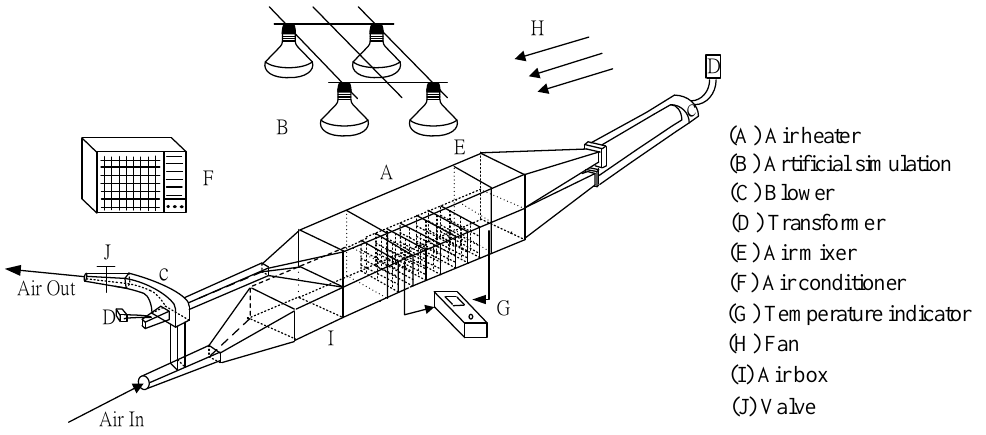
Figure 3. Experimental setup of a wire mesh packed double-pass solar air